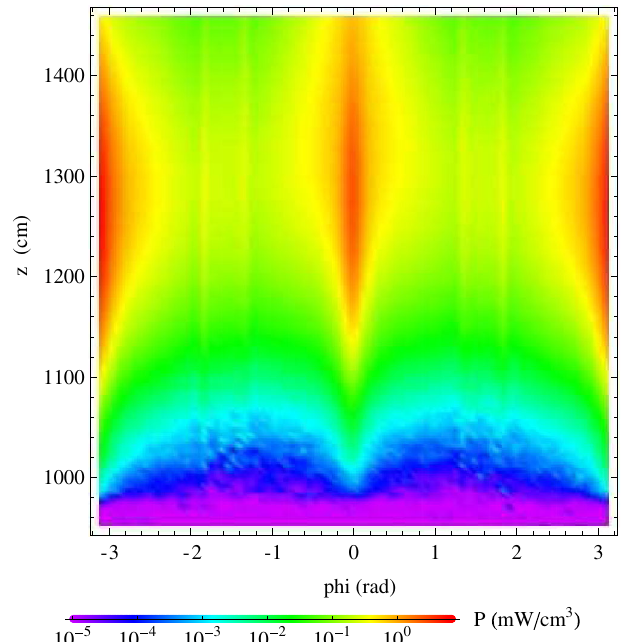
FIG. 7. (Color) The heating power from beam losses caused by BFPP in the inner layer of the coil of an LHC main dipole as simulated with FLUKA . The power density was averaged over the width of the cable and is shown as a function of azimuthal angle (cid:11) and longitudinal coordinate z , with z ¼ 0 in the beginning of the magnet. The beam loss is centered around z ¼ 1206 cm and (cid:11) (cid:2) (cid:1) 3 : 11 rad